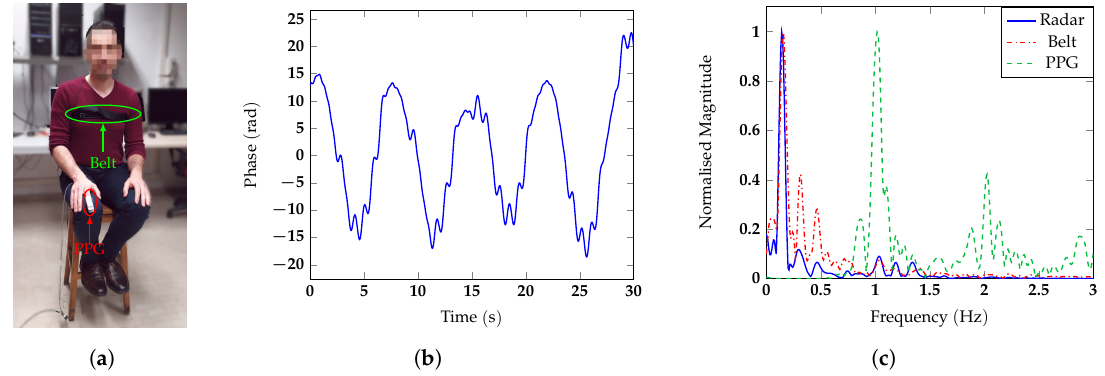
Figure 7. ( a ) Photo of the experimental setup in which the chest of the subject is facing the antenna; ( b ) vital signs extracted by the radar in the time domain and ( c ).